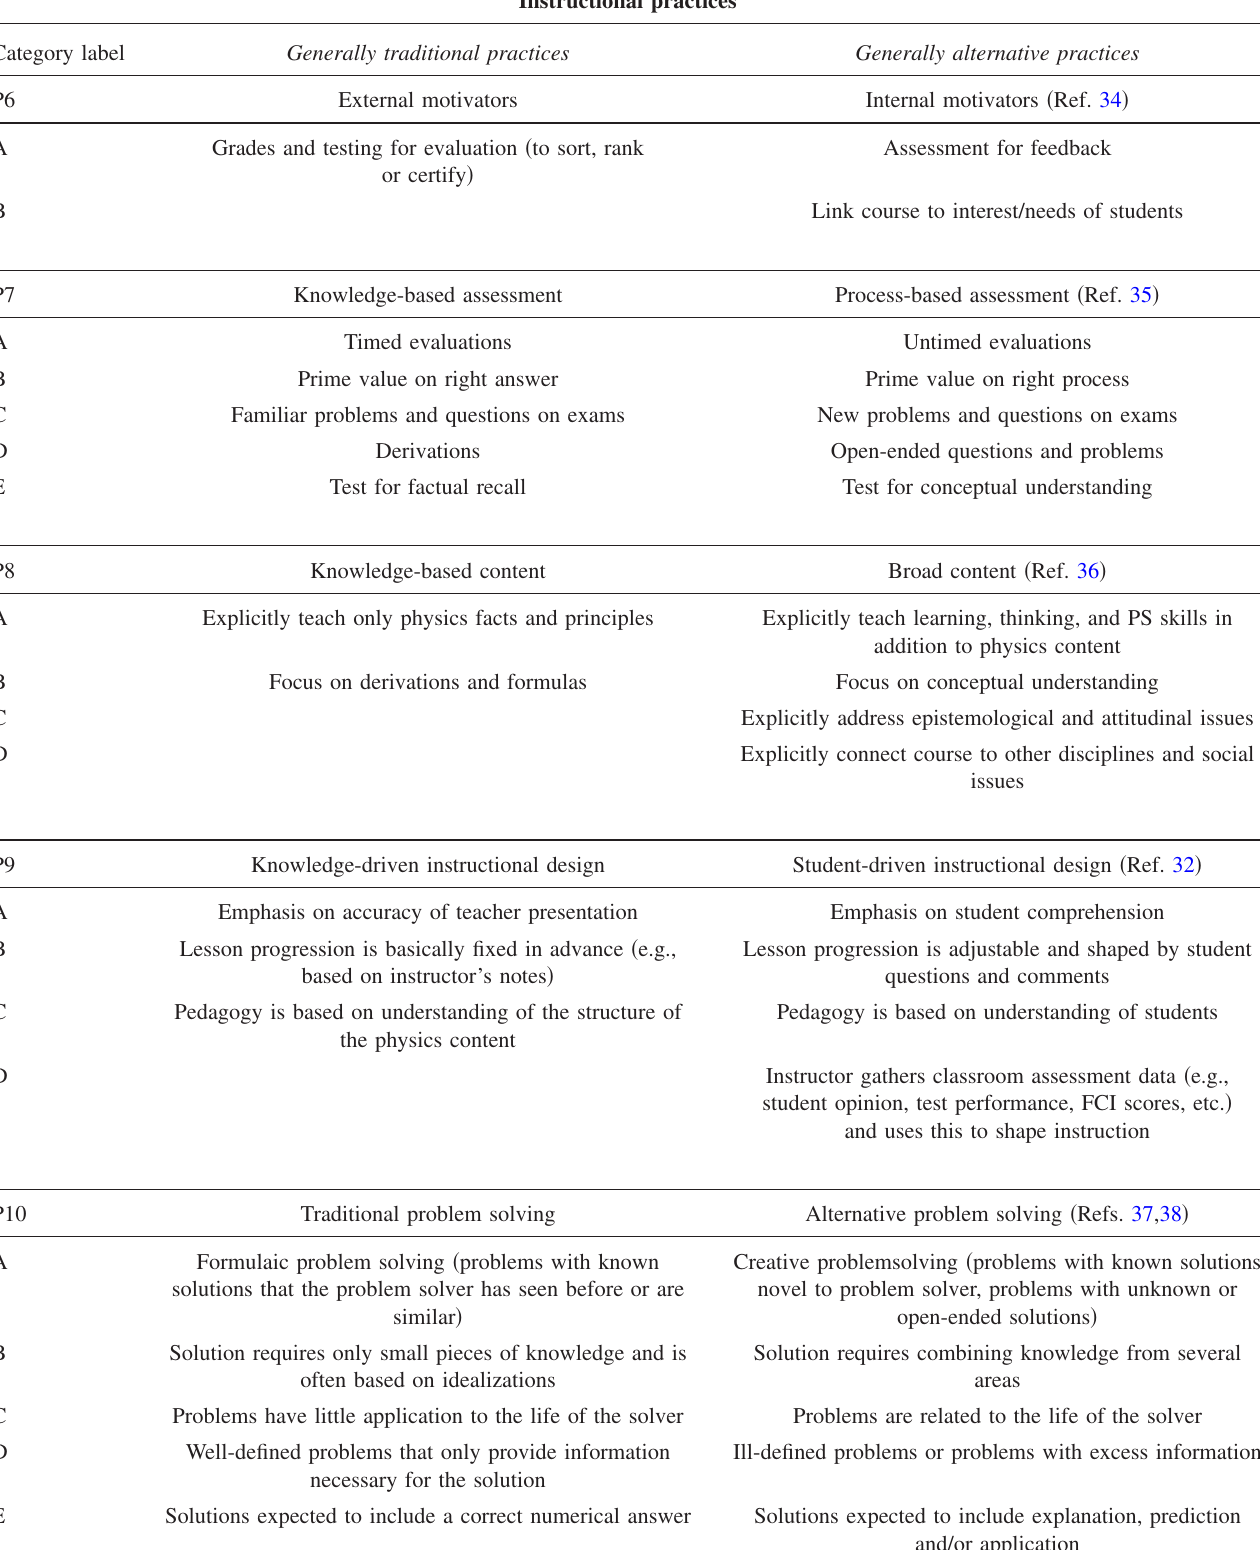
TABLE V. (cid:1) Continued. (cid:2) Instructional